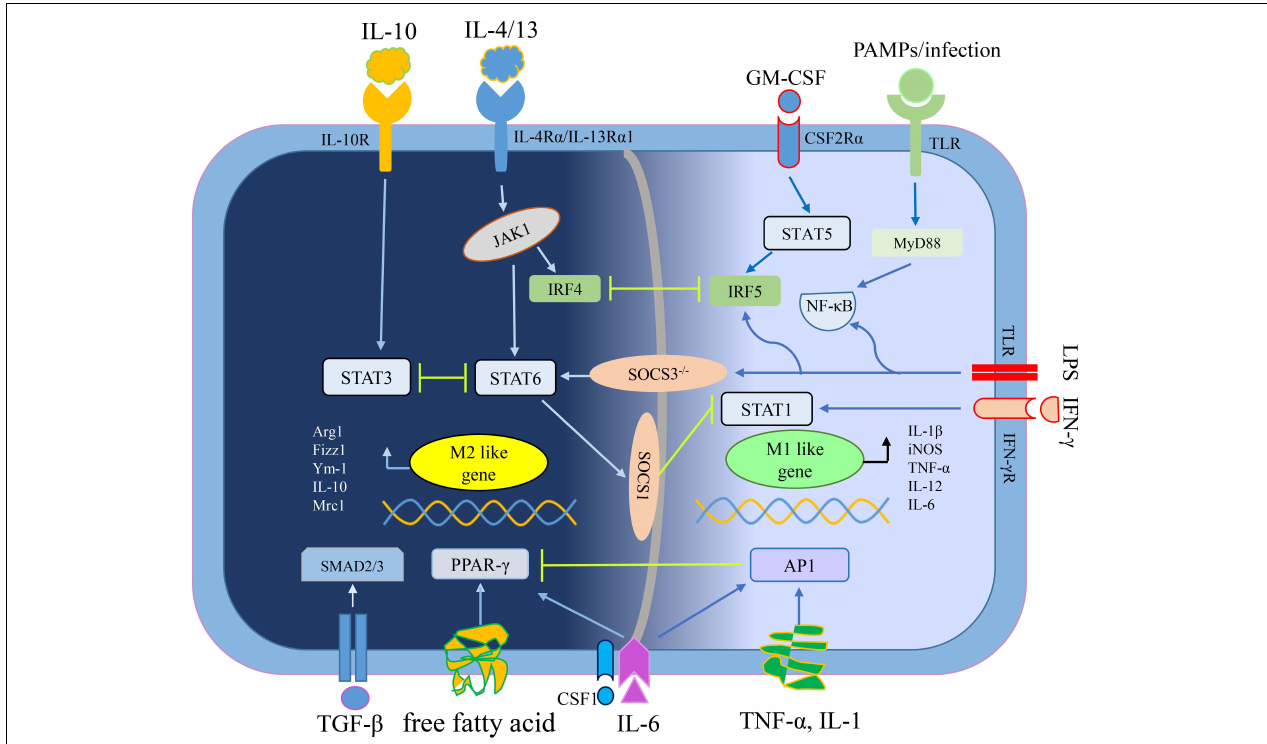
FIGURE 1 | The mechanisms of macrophage polarization. IL-4/13 mediates macrophage polarization toward M2 macrophages depending on STAT6 signaling, whereas IL-10 depending on STAT3 signaling (Lang et al., 2002; Sica and Mantovani, 2012). Free fatty acid or IL-6 plus CSF1 enhance PPAR- γ expression to educate M2 macrophage (Odegaard et al., 2007; Wang et al., 2018b). TGF- β secreted by tumor cells and M2 macrophages promoted M2 polarization of TAMs through Smad3 signaling pathways (Gordon and Martinez, 2010). Interferon- γ (IFN- γ ) mediates macrophage polarization toward M1 macrophages relying on STAT1 signaling while other stimuli (like LPS and PAMPs/infections) convert macrophages into M1 phenotype relying on NF- κ B signaling (Muraille et al., 2014). GM-CSF mediates macrophage polarization toward M1 macrophages through STAT5 signaling while pro-inflammatory cytokines (including TNF- α , IL-1, and IL-6) depending on AP1 signaling (Liu Y. C. et al., 2014; Wang N. et al., 2014). By the way, the crosstalk between activation of STAT3/STAT6 and STAT1, closely regulates macrophage polarization (Ohmori and Hamilton, 1997). Abbreviations: colony stimulating factor 1 (CSF1), esistin-like- α (Fizz1), Arginase1 (Arg1), chitinase 3-like 3 (Ym1), inducible nitric oxide synthase (iNOS), signal transducer and activator of transcription (STATs), interferon-regulatory factor (IRFs), nuclear factor (NF)- κ B, activator protein (AP) 1, peroxisome proliferator-activated receptor (PPAR)- γ , pathogen associated molecular patterns (PAMPs), suppressor of cytokine signaling (SOCS), small mother against decapentaplegic